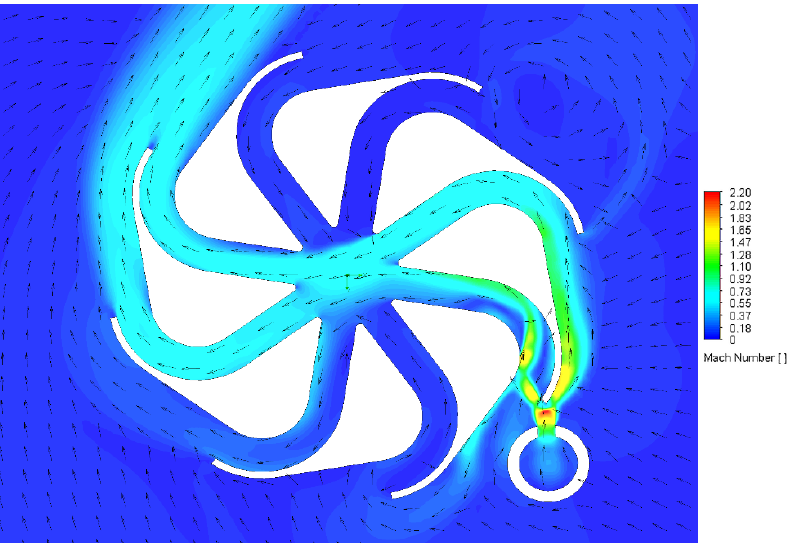
Figure 11. Computer simulation results for the turbine with an external working gas inlet (Operation mode 4). Source: authors’ development.